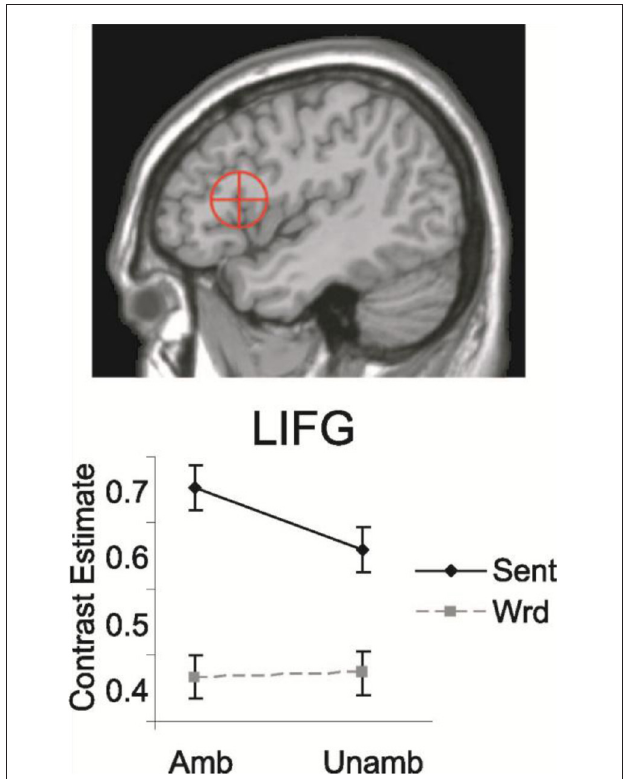
FIGURE 7 | Mean contrast estimated for LIFC for sentences and word sequences, with (Amb) and without (Unamb) noun-verb ambiguities. On top the Region of Interest [ROI; 13mm sphere around coordinates ( − 44, 19, 14)] is shown. This ROI includes both BA 44 and parts of BA 45 (Snijders et al.,